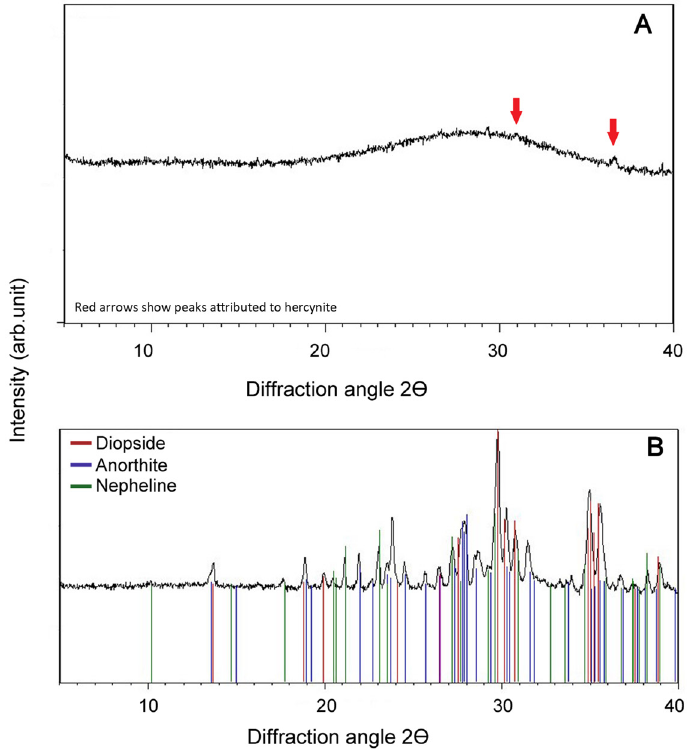
Figure 2. Diffractometric patterns of the investigated flotation mud FM ( A ) and related ceramic product CFM ( B ). Red arrows show peaks attributed to hercynite.